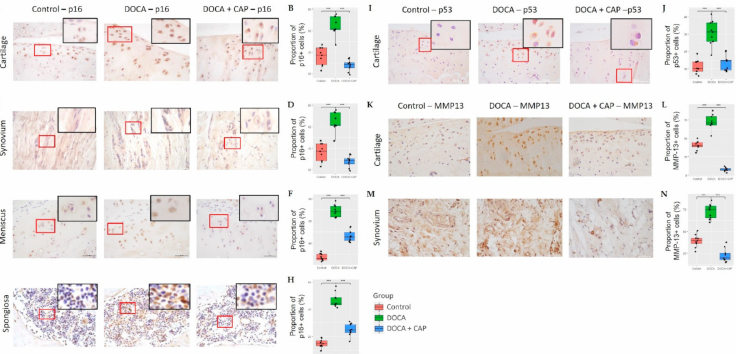
Figure 2. The p16 staining results of cartilage ( A ), synovium ( C ), meniscus ( E ), and secondary spongiosa ( G ) are shown with the red boxes indicating the p16- positive regions. The percentage of p16-positive cells in the ( B ) cartilage, ( D ) synovium, ( F ) meniscus, and ( H ) secondary spongiosa in Control (red), DOCA (green), and Captopril-treated group (blue) are plotted. ( I , J ) The results of p53 staining of cartilage and the percentage of p53-positive cells in the sample. The MMP13 staining of the ( K , L ) cartilage and ( M , N ) synovium of the Control, DOCA, and DOCA + Captopril groups, respectively. (*** p < 0.001).